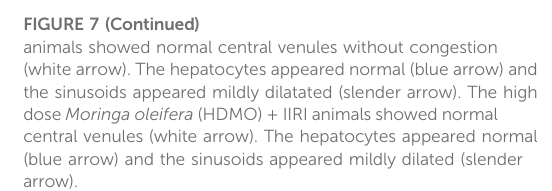
(blue arrow) and the sinusoids appeared mildly dilated (slender